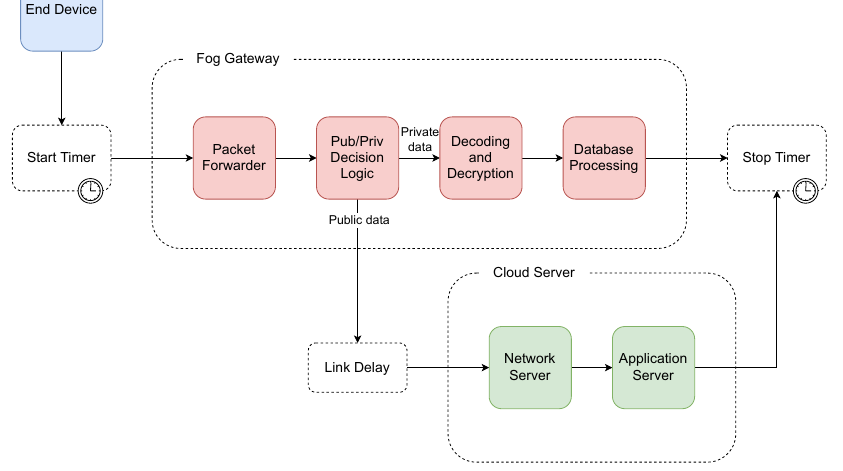
Figure 7. Diagram of the simulation model of architecture